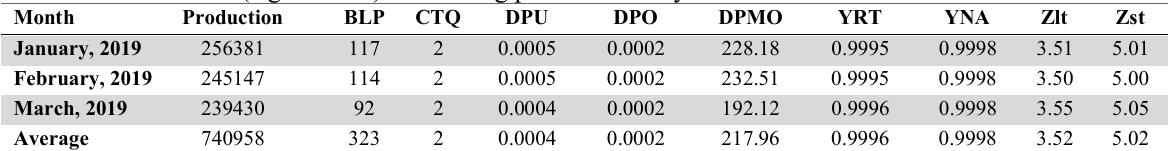
Performance baseline (sigma level) of building process January ~ March 2019